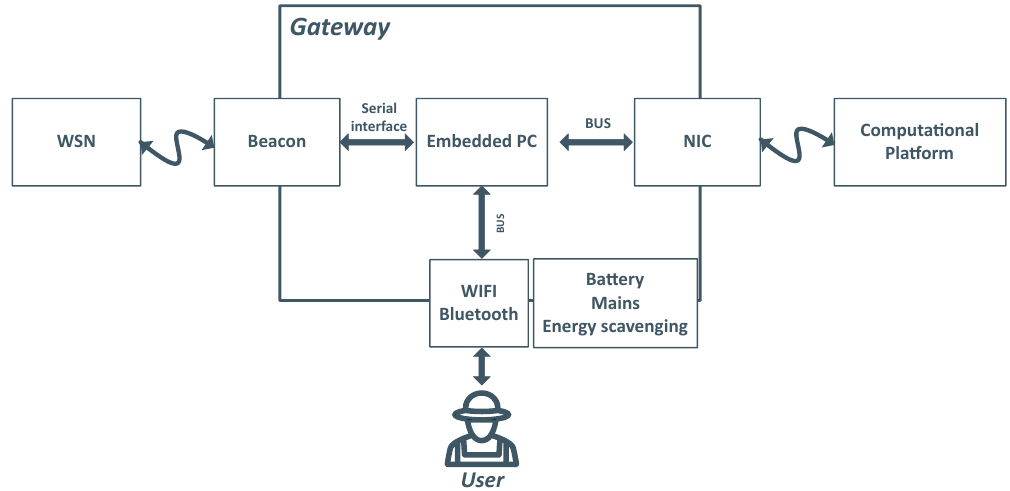
Figure 8. Gateway internal